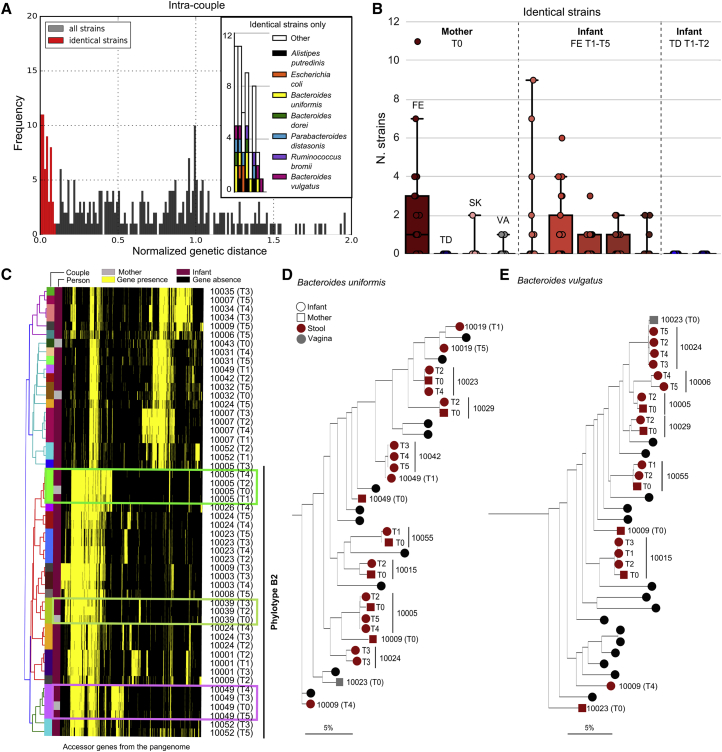
Strain Transmission between Mothers and Their Infants(A and B) The distribution of the normalized strain intra-pair distances (STAR Methods) (A) and the number of vertical transmitted strains for each maternal source and each infant recipient body site and time point (B).(C) Escherichia coli strain-specific gene content as identified by PanPhlAn. Strains with clear evidence of vertical transmission are indicated with boxes.(D and E) Mother-infant phylogenies for Bacteroides uniformis and Bacteroides vulgatus as inferred by StrainPhlAn. Maternal body sites are represented by squares and infant body sites by circles. Mother-infant pairs with at least two samples are labeled with the pair ID in the trees (black circles otherwise).